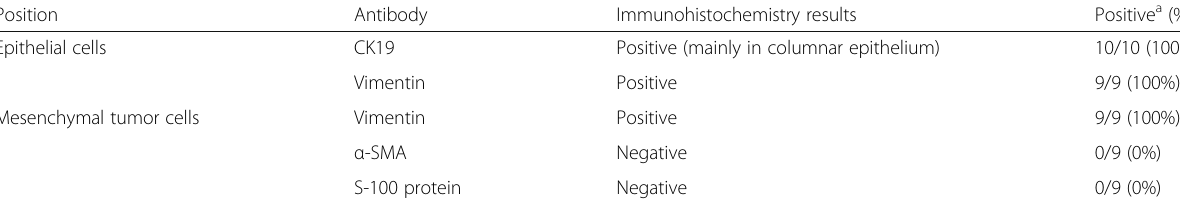
Table 3 Immunohistochemistry results of the previous cases and current case Position Antibody Epithelial cells